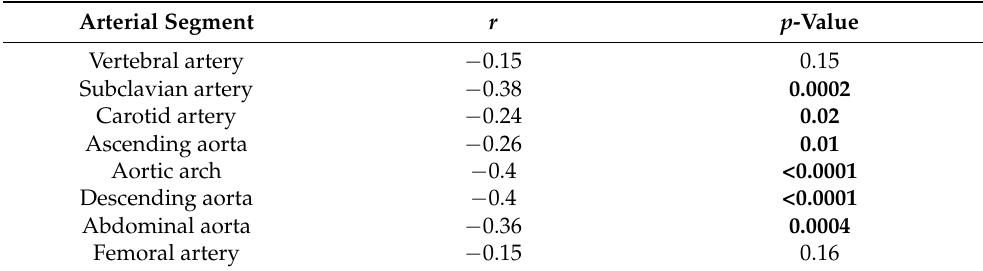
Table 6. Correlations between the vessel wall-to-liver ratio of each arterial segment with prednisone dosage ( n =